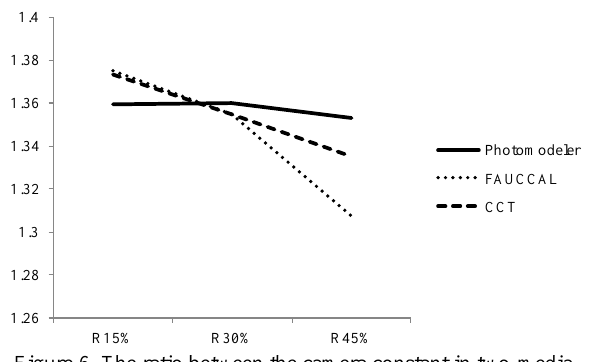
Figure 6. The ratio between the camera constant in two-media and the one in air.